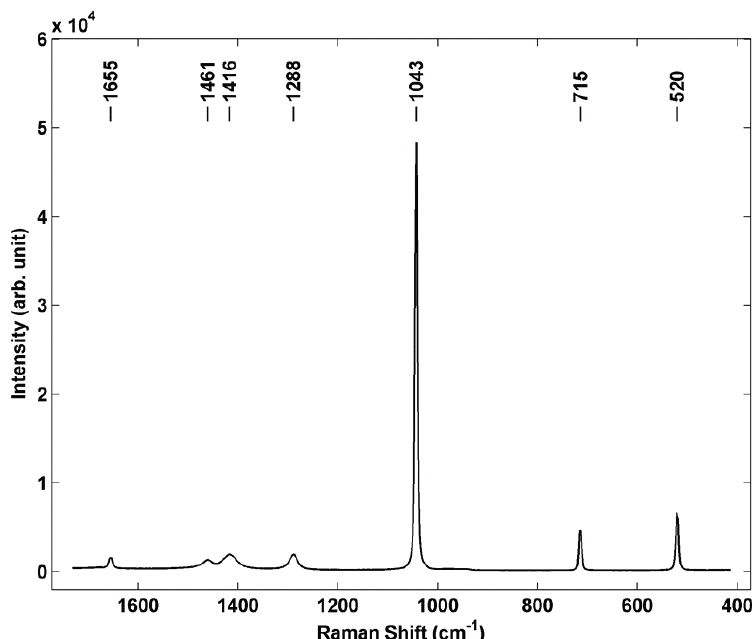
Figure 6. Micro Raman spectrum of individual AN particle prepared by inkjet printing. Renishaw S1000 Micro Raman system, 532 nm excitation, 50×, ≈ 1 mW power at sample, 10 s